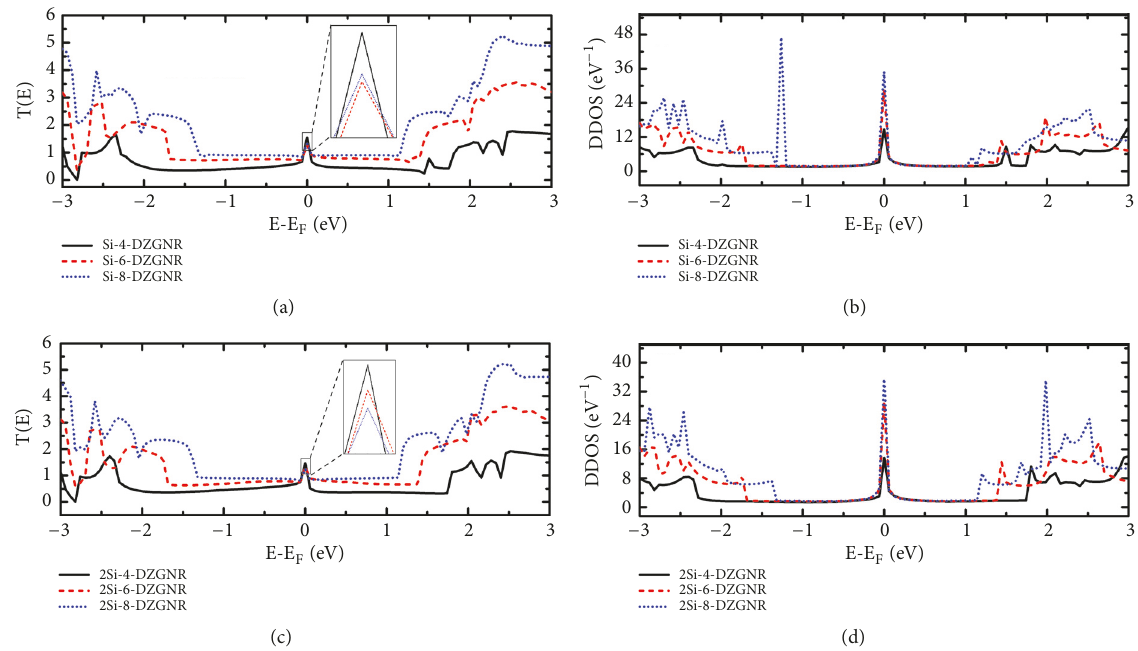
Figure 3: The same plot as Figure 2, the results are shown for distorted graphene with a single (a) and a double (c) middle substitution with Si atoms for four zigzag chains (solid-black curve) and for six zigzag chains (short-dashed-red curve) and for eight zigzag chains (short-dotted- blue curve) in